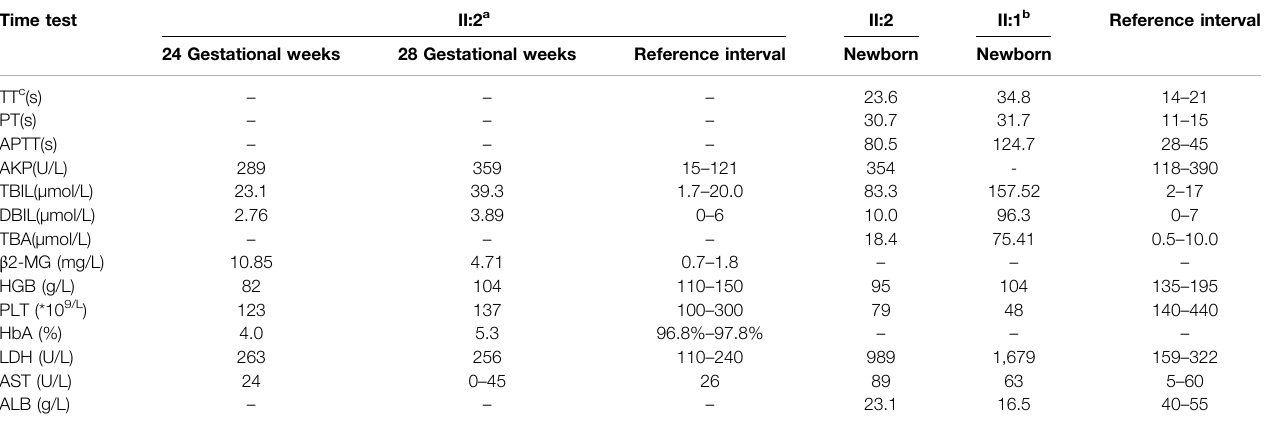
TABLE 2 | The laboratory results of II:2 as determined directly in 24+ and 28+ weeks through the umbilical cord blood tests and after birth between II:1 and II:2. Time